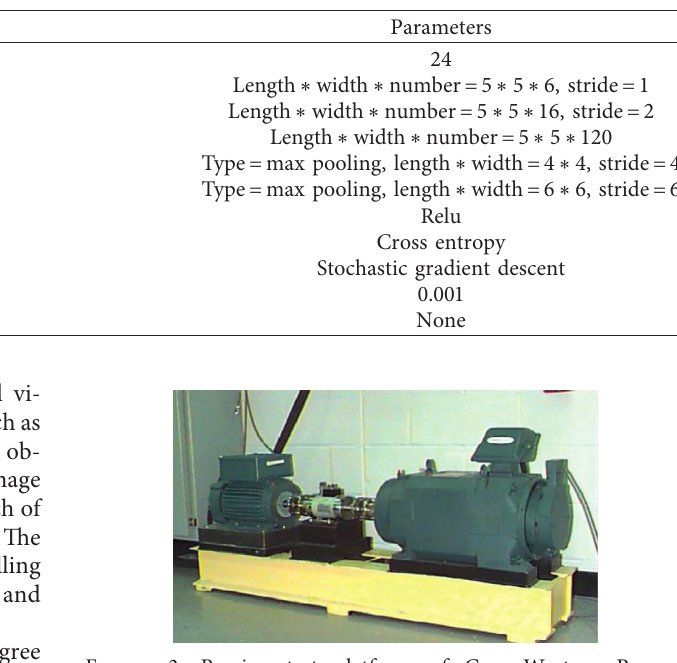
Figure 2: CNN model structure diagram. Table 1: CNN model parameters preset.